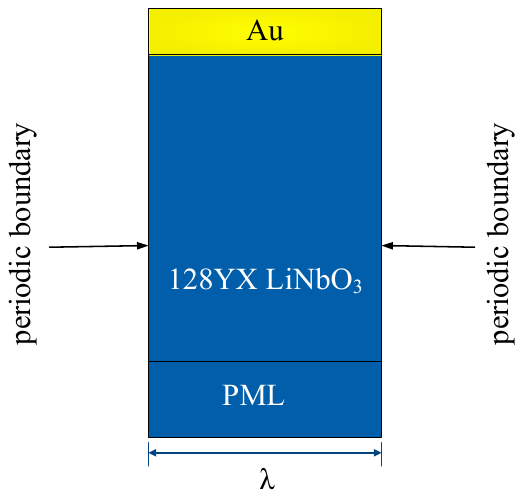
Figure 2. Two-dimensional (2D) periodic finite element method (FEM) model without Al electrodes used in the simulation.